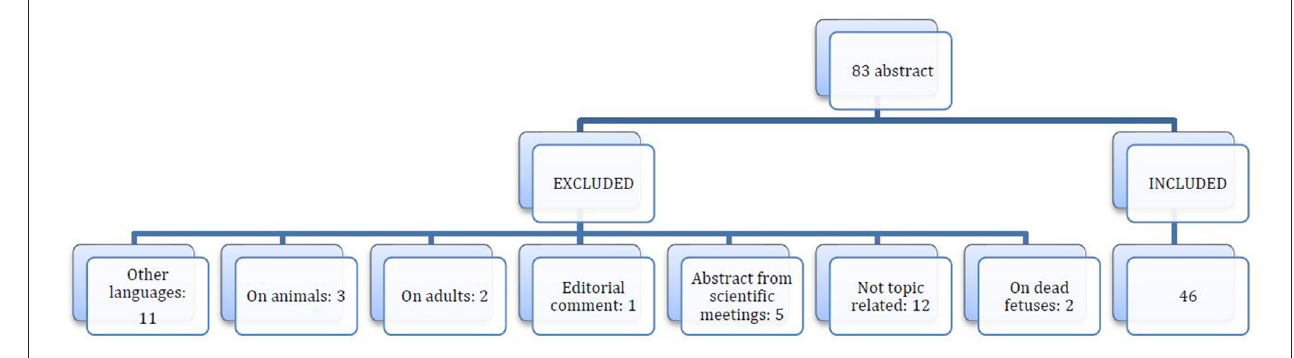
FIGURE 3 | PRISMA flow